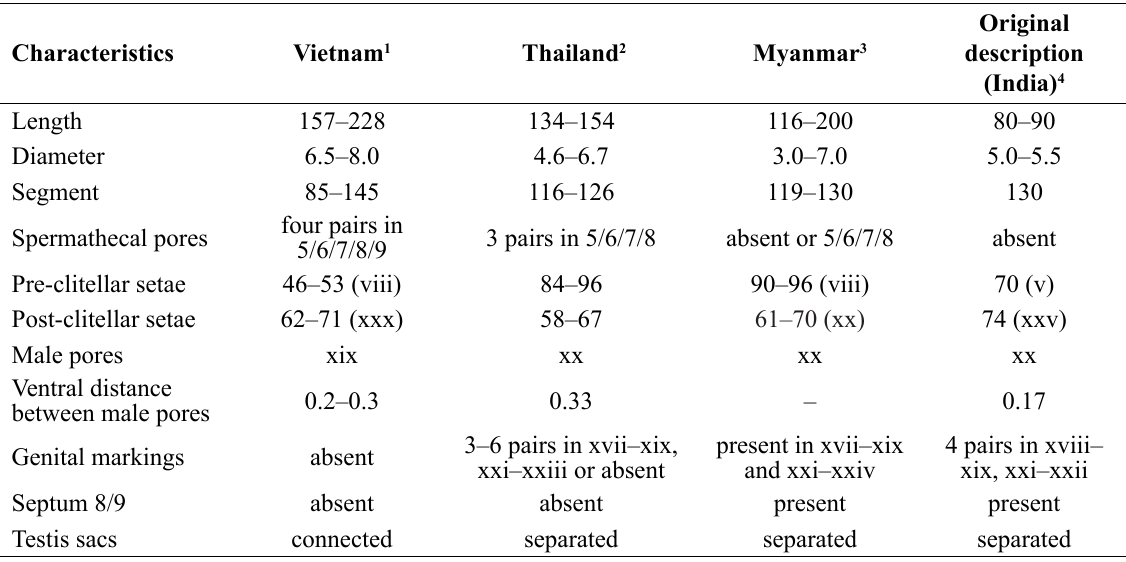
Table 2. Comparison between M. iranomala sp. nov. and M. anomala (Michaelsen, 1907) from Thailand, Myanmar and India (its original description).